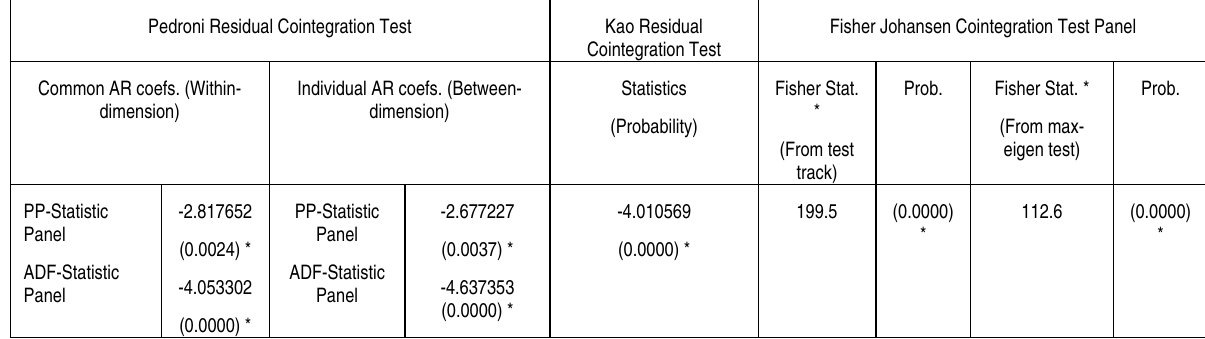
Table 6. The cointegration test of the impact of FDI on sustainable development for countries of North